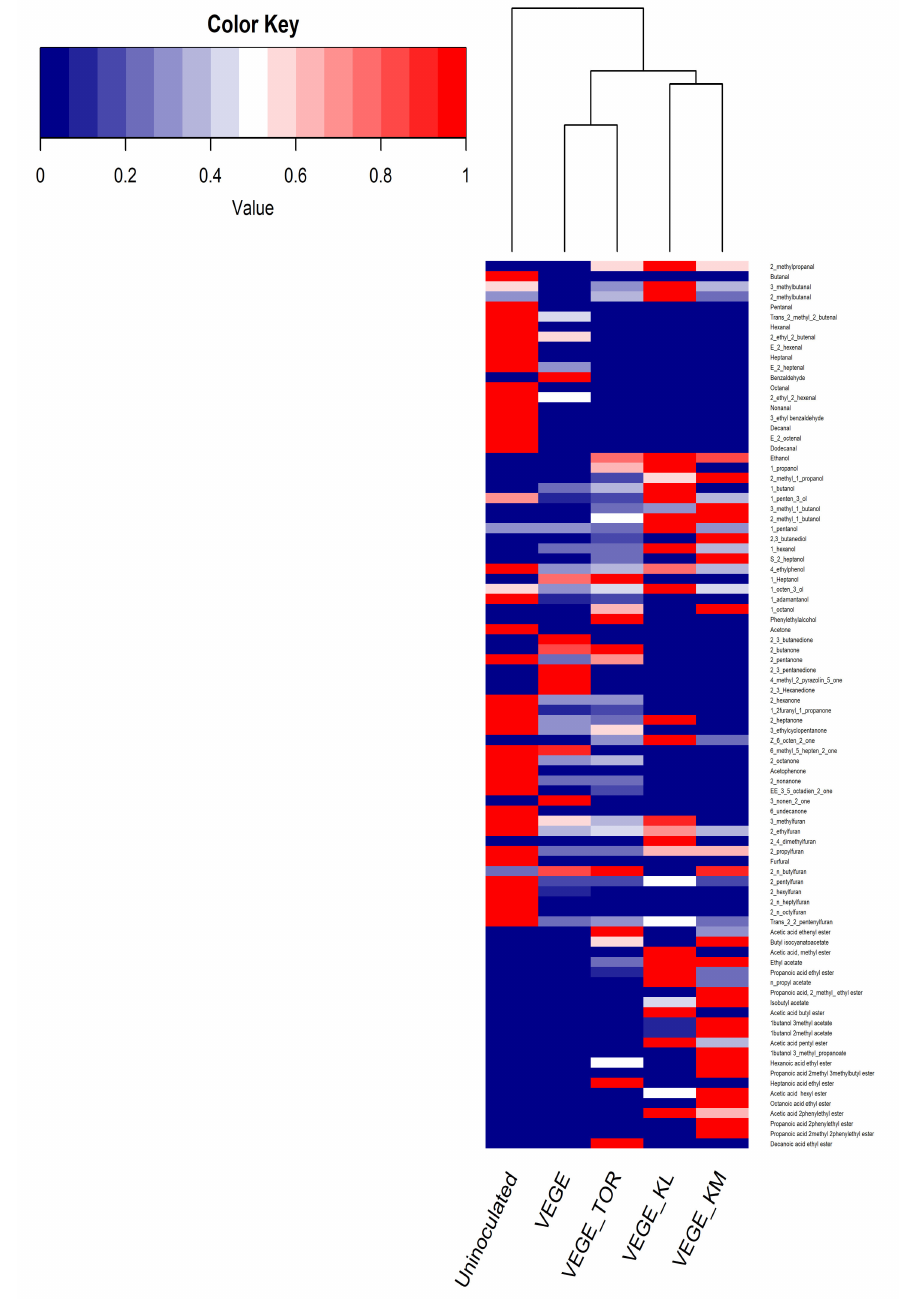
Figure 2. A hierarchically clustered heat map showing the patterns of the di ff erent samples for the identified volatile